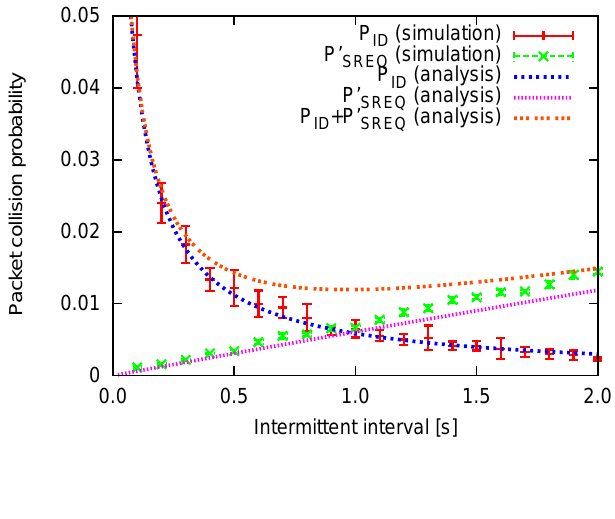
Figure 9. Probability of control packet